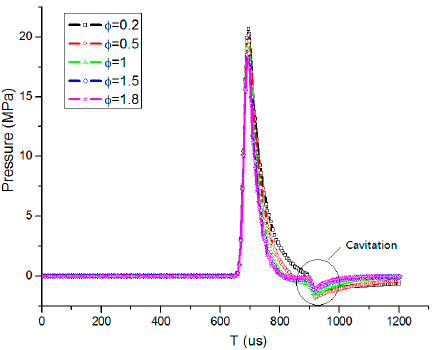
Figure 12. The one-dimensional shock wave calculation (pressure contours) of Taylor’s Problem using LSDYNA.